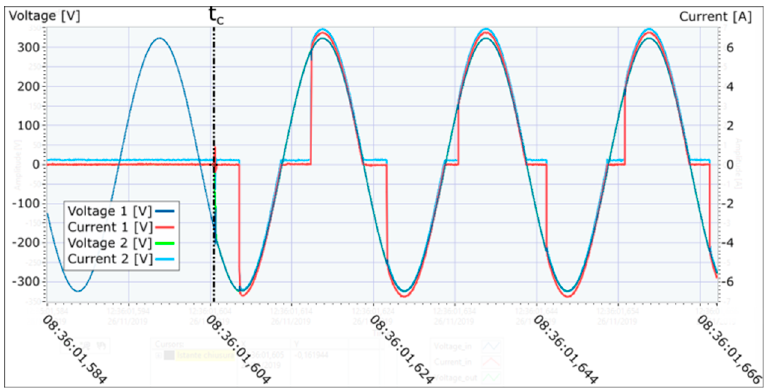
Figure 19. Instant ( t c ) at which the arc was formed (using the Bourns 2049-25 surge arrester).